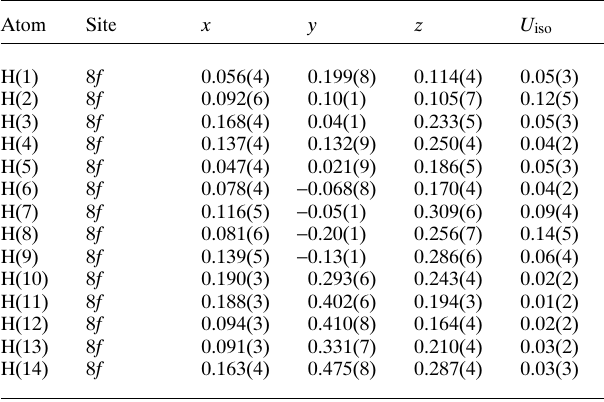
Table 2. Atomic coordinates and displacement parameters (in Å 2 )